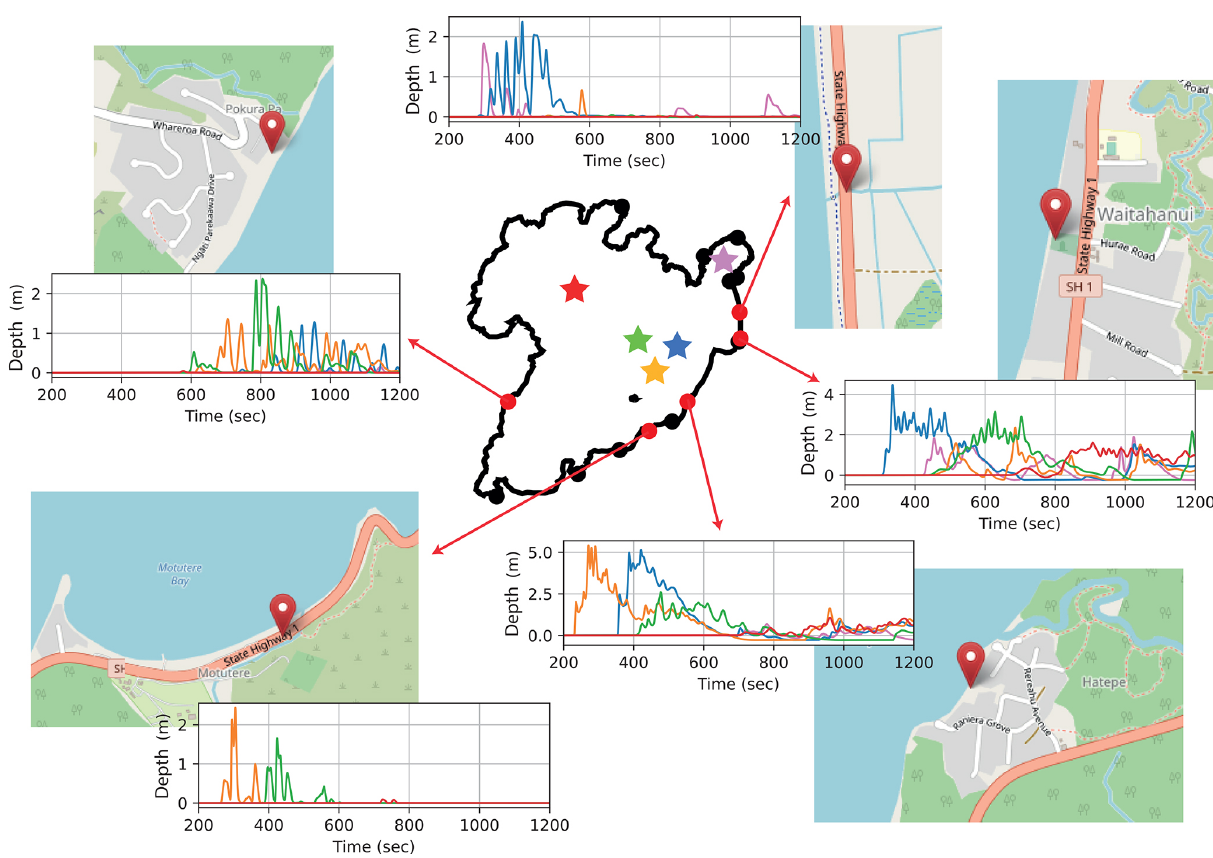
Figure 10. Inundation depth time series for the largest size sources, coloured by location and indicated by stars in the central map. Map imagery © OpenStreetMap contributors 2022. Distributed under the Open Data Commons Open Database License (ODbL)